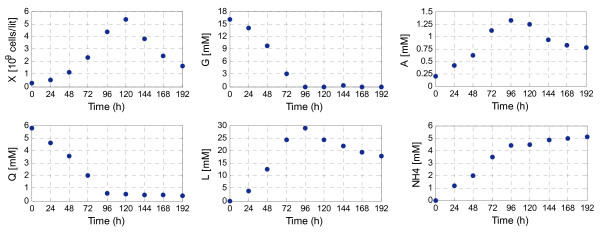
Concentration of measured extracellular species and biomass during a cultivation of CHO cells. The measurements correspond to cell density (X), glucose (G), glutamine (Q), lactate (L), alanine (A) and ammonia (NH4).